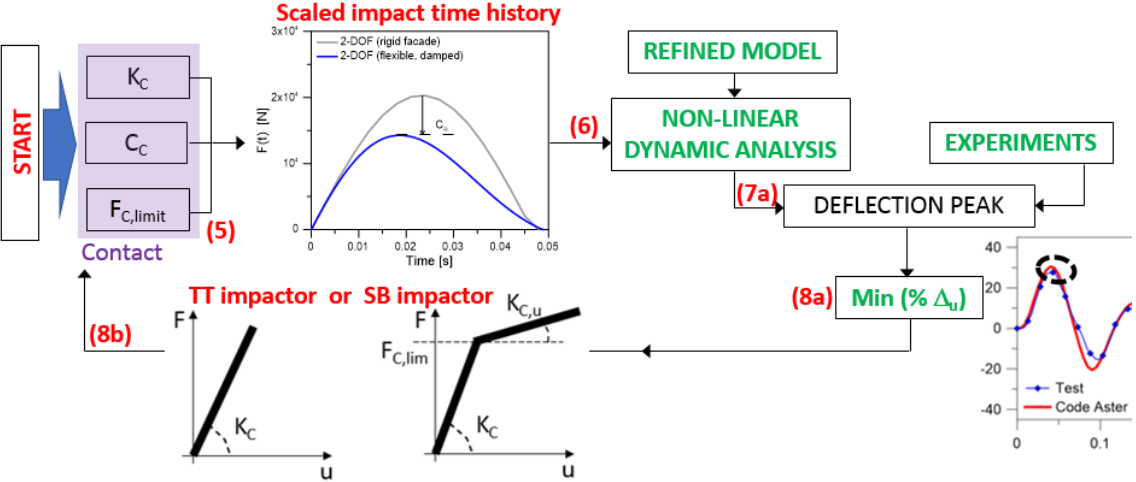
Figure 19. Developed calibration procedure for the 2-DOF input parameters of the impact contact, depending on the impactor in use (linear elastic for TT, elasto-plastic with hardening for SB).